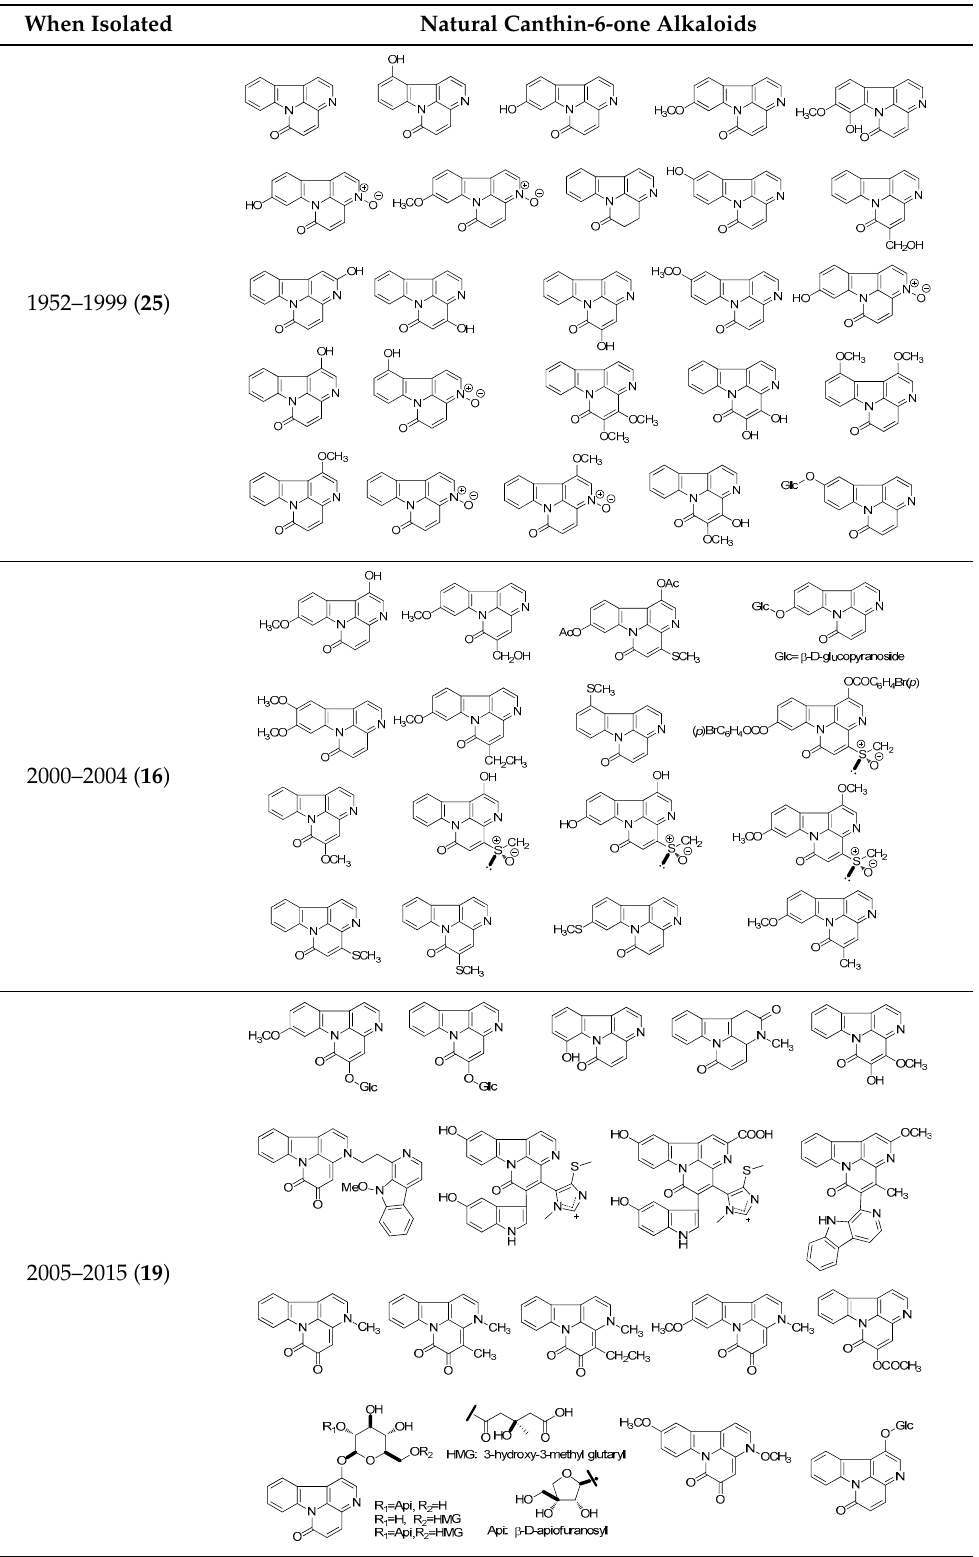
Table 1. Representative canthin-6-one alkaloids isolated from natural sources.